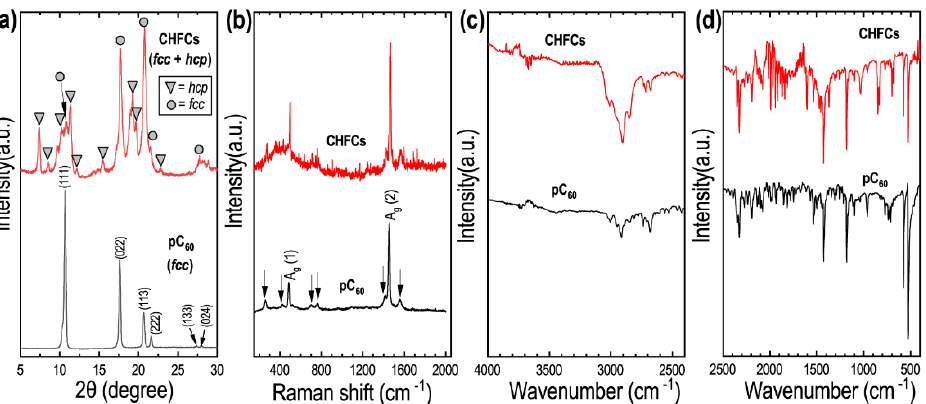
Figure 3. Characterizations of pC 60 and the self-assembled CHFCs: ( a ) Powder X-ray diffraction (pXRD); ( b ) Raman scattering spectra; ( c ) FT-IR spectra in high wavenumber region; ( d ) Corresponding FT-IR spectra in low wavenumber region.